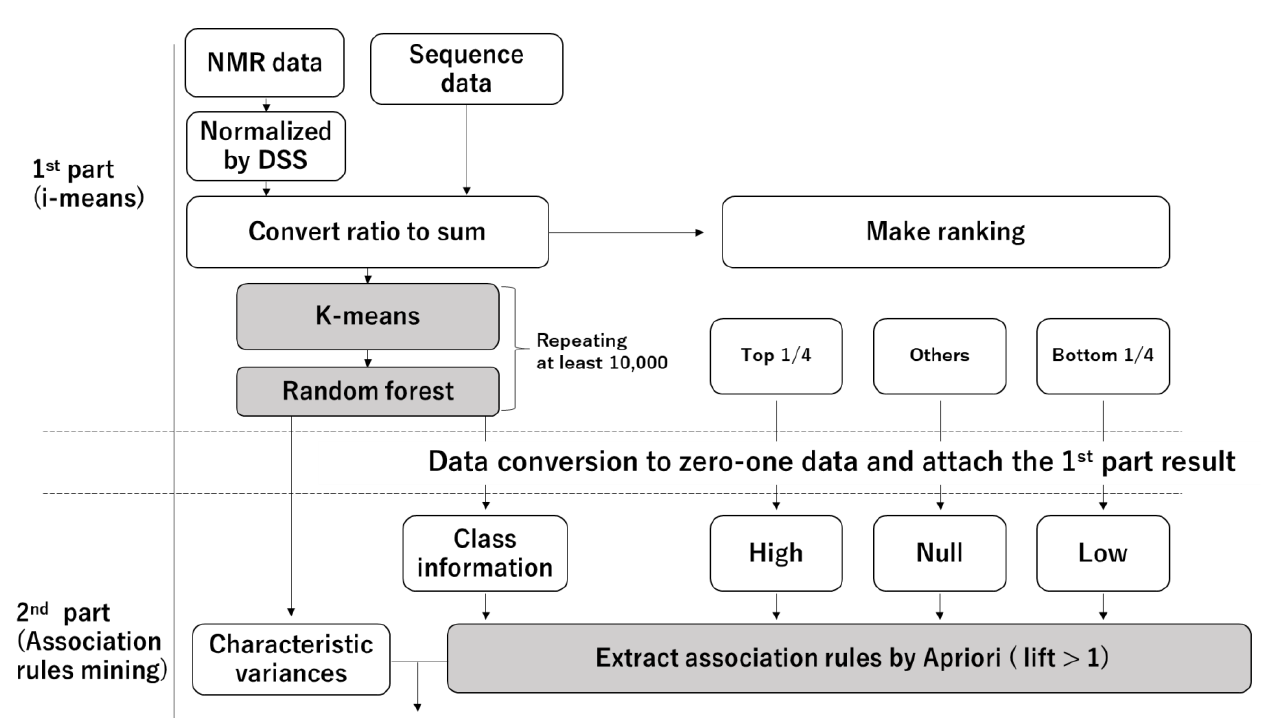
Figure 1. Overview of our proposed analysis.